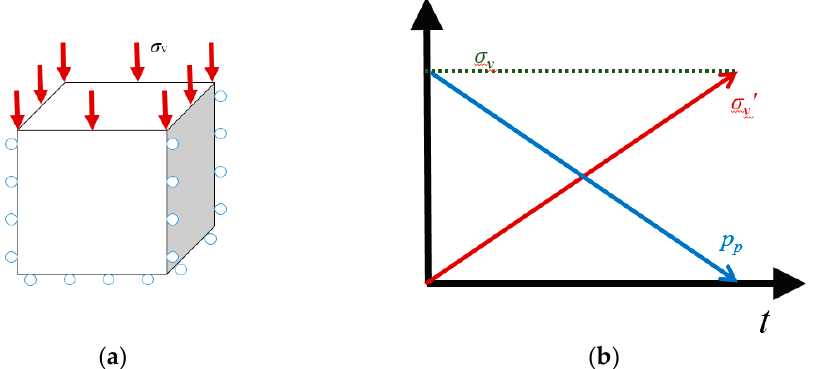
Figure 1. Compression model ( a ) 1D compaction model and ( b ) increase in effective stress with decreasing pore pressure.